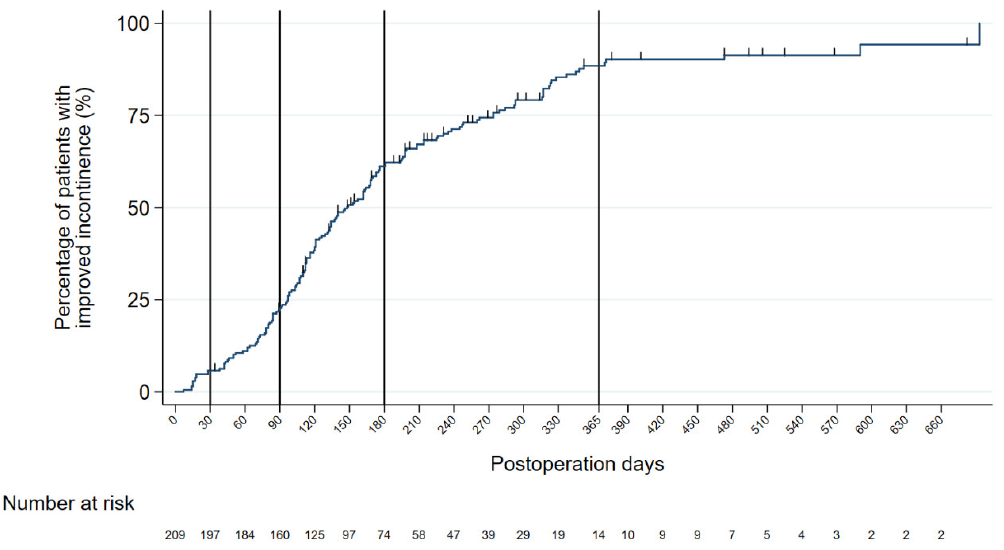
Figure 1. Recovery rate of postoperative urinary incontinence estimated with the Kaplan–Meier product limit method.